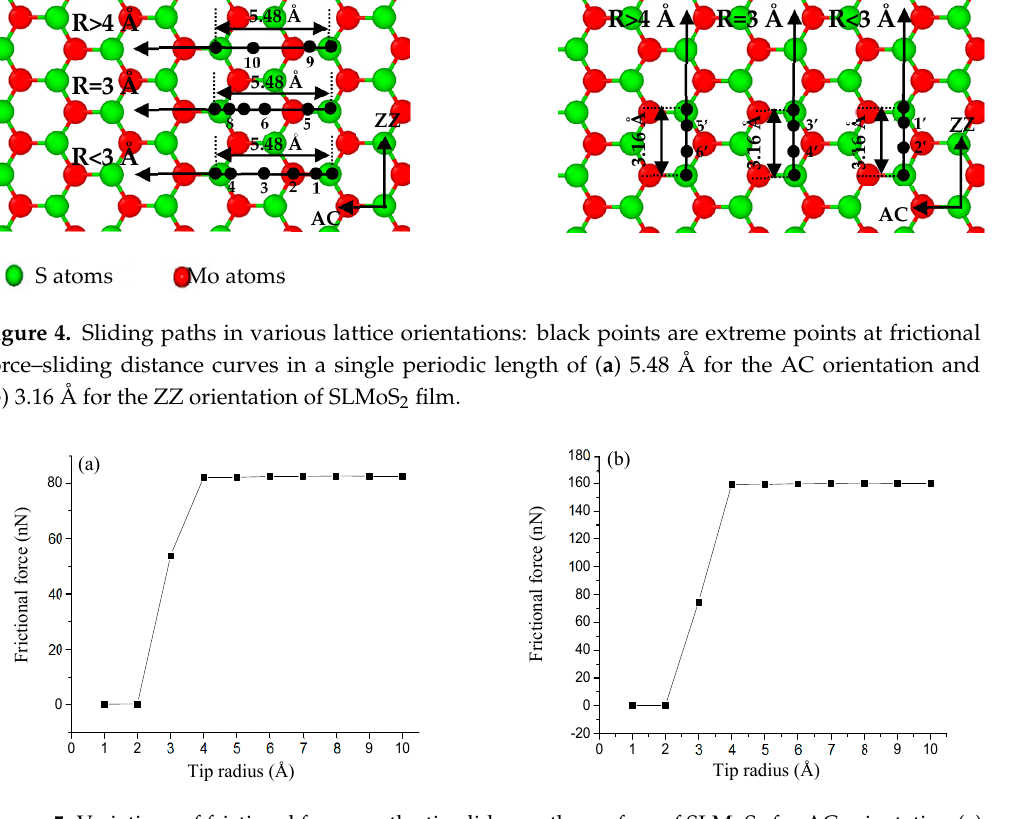
Figure 5. Variations of frictional forces as the tip slides on the surface of SLMoS 2 for AC orientation ( a ) and ZZ orientation ( b ) with 10 different radii, 1, 2, 3, 4, 5, 6, 7, 8, 9, and 10 Å.